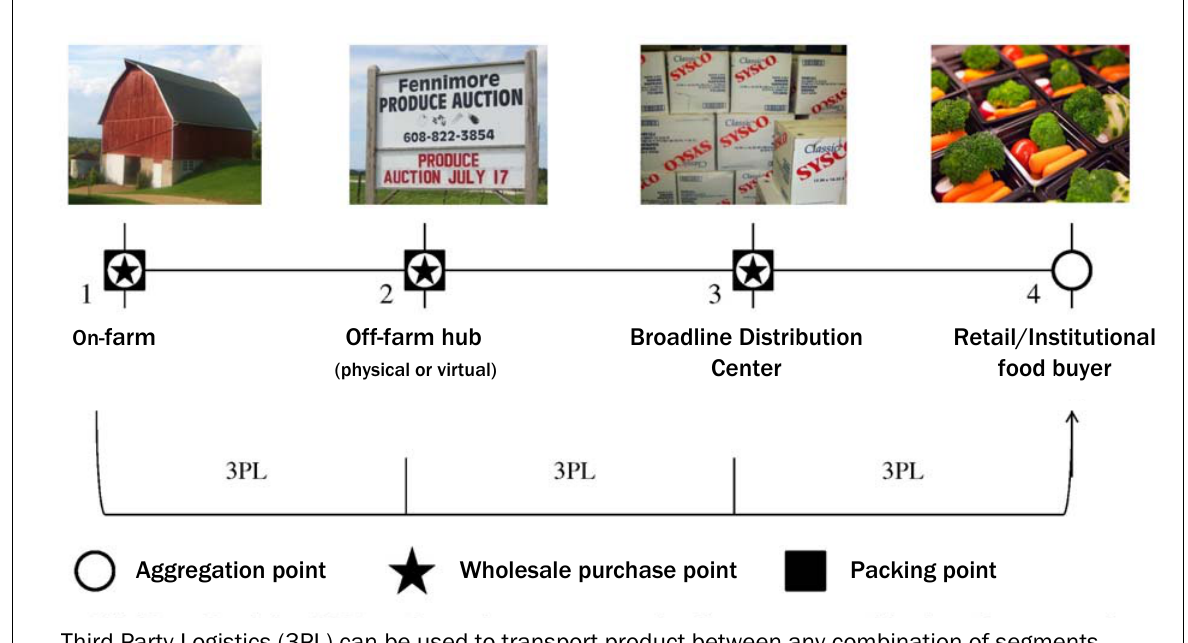
Third Party Logistics (3PL) can be used to transport product between any combination of segments of the supply